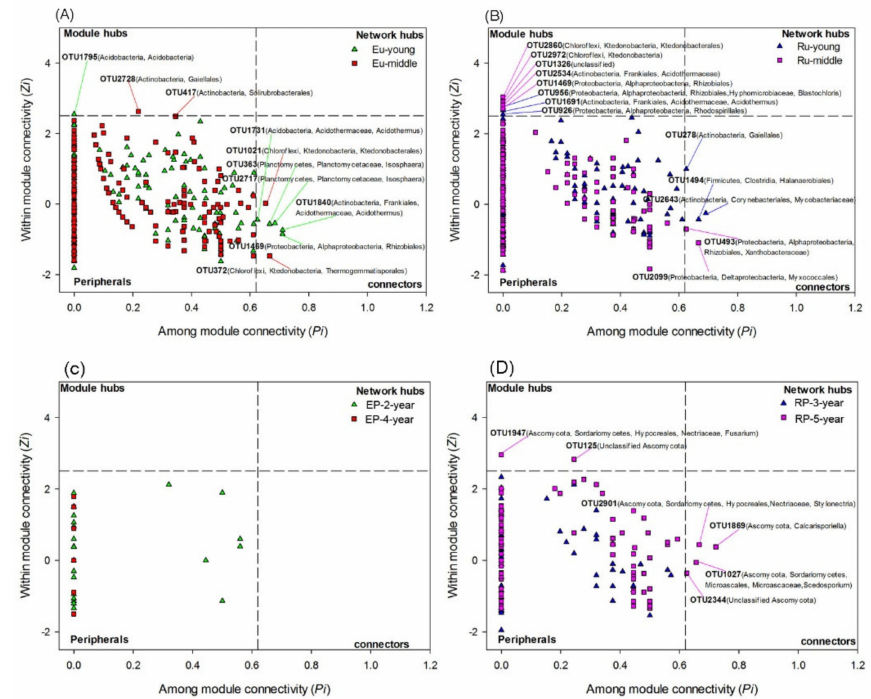
Figure 8. Topological roles of OTUs in the bacterial and fungal co-occurrence networks as indicated by the Zi-Pi plot. ( A , C ) The Zi-Pi plot of soil bacterial and fungal networks in 2-year-old and 4-year-old Eucalypt plantations (EP-2-year and EP-4-year). ( B , D ) The Zi-Pi plot of soil bacterial and fungal networks in 3-year-old and 5-year-old Rubber plantations (RP-3-year and RP-5-year). Network module hubs and connectors represent keystone taxa and are labeled with their OTU numbers and taxonomic a ffi liations. The nodes with Zi > 2.5 are identified as module hubs, and those with Pi > 0.62 are connectors. The network hubs are determined by Zi > 2.5 and Pi > 0.62, and the peripherals are characterized by Zi < 2.5 and Pi < 0.62 [47].